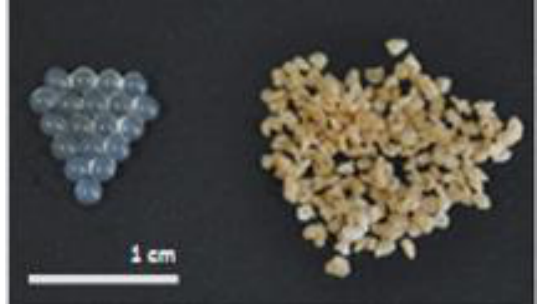
Figure 2. Comparison of morphology and particle size between newly prepared (left) and dried (right) microparticles.